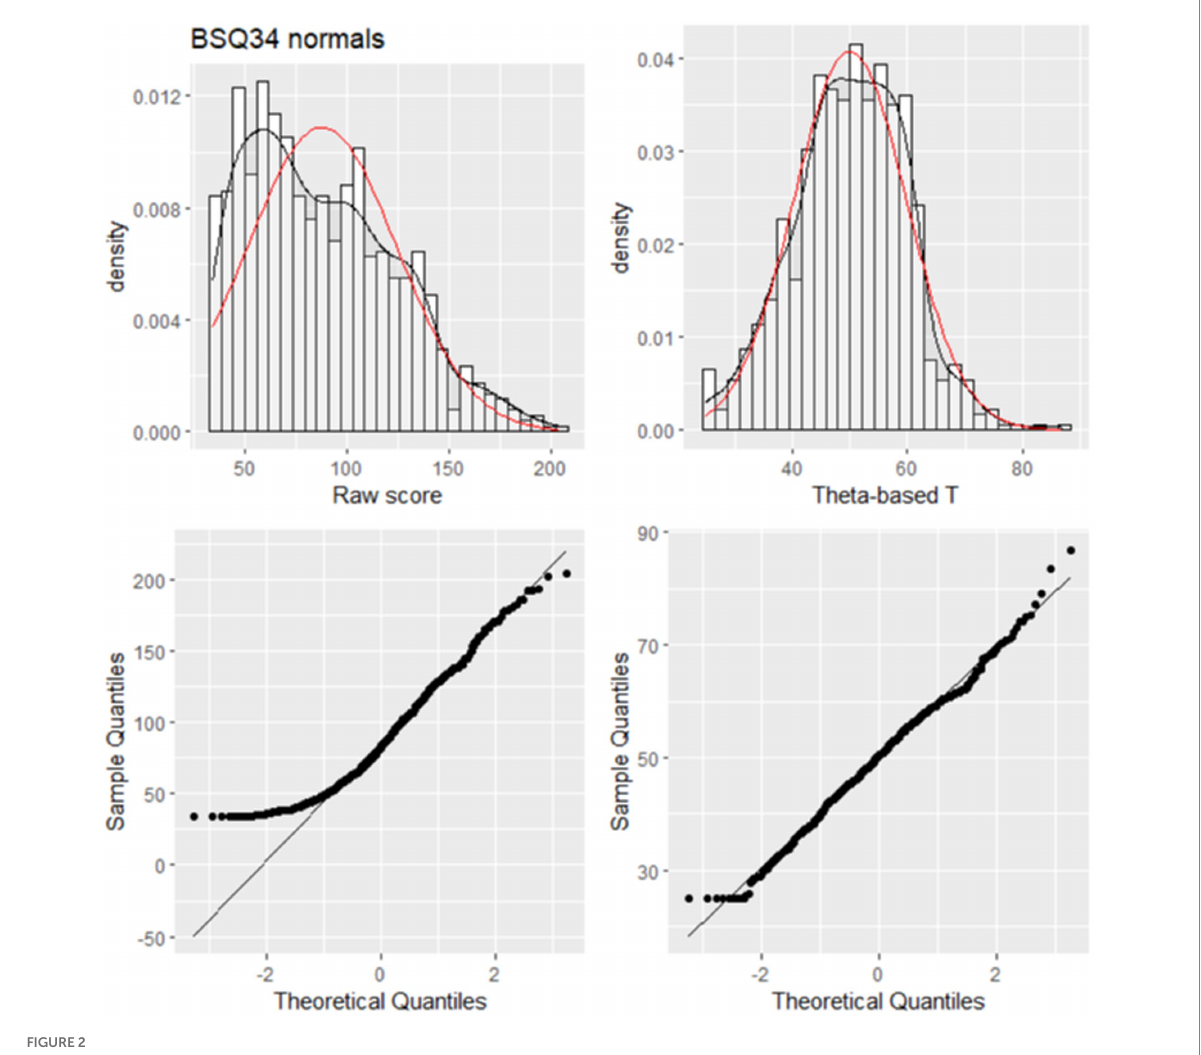
FIGURE 2 Histogram and normal probability plot for the